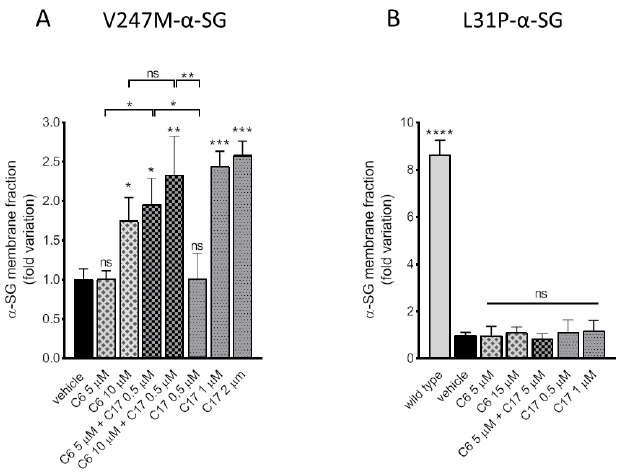
Figure 4. CFTR correctors C6 and C17 are effective on the mutant V247M only . ( A ) HEK293 cells constitutively expressing the V247M mutant of α-SG and ( B ) HEK293 cells transiently expressing the L31P mutant of α-SG were treated for 24 h with either 1‰ DMSO (vehicle), C6, C17 or C6 + C17 at the indicated concentrations. At the end of incubation, cells were lysed and, after quantification, 50 µg of proteins were subjected to pull down assay by streptavidin-conjugated agarose beads. Recovered surface proteins were analyzed by SDS-PAGE and western blot with antibodies against α- SG. Representative western blots are reported in Figure S5. In B, it is reported for comparison the level of a-SG expressed by cells transiently transfected with the wild type form of the protein. Quantification of α-SG content was performed by densitometric analysis. Values are the mean (+/− SD) of 3 independent experiments (each performed in duplicate) and are reported as fold increase of the amount present in the control sample. Statistical analysis was performed by One-way ANOVA test followed by multiple comparisons Tukey’s test; n.s., p > 0.05; *, p ≤ 0.05; **, p ≤ 0.01; ***, p ≤ 0.001, ****, p ≤